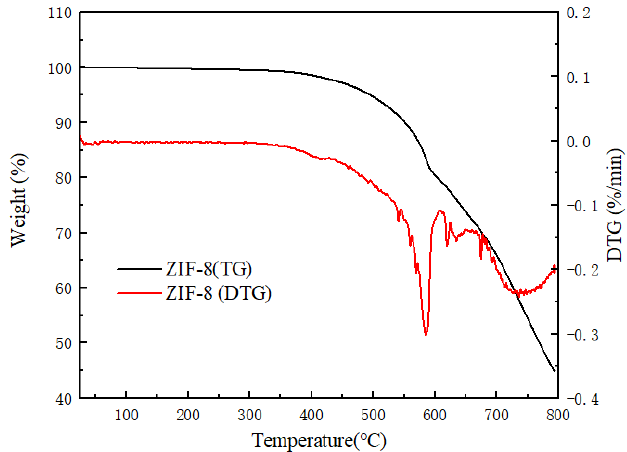
Figure 5. The TG and DTG of the ZIF-8 nanocomposites. Table 1. Surface area and porous structure of the ZIF-8.